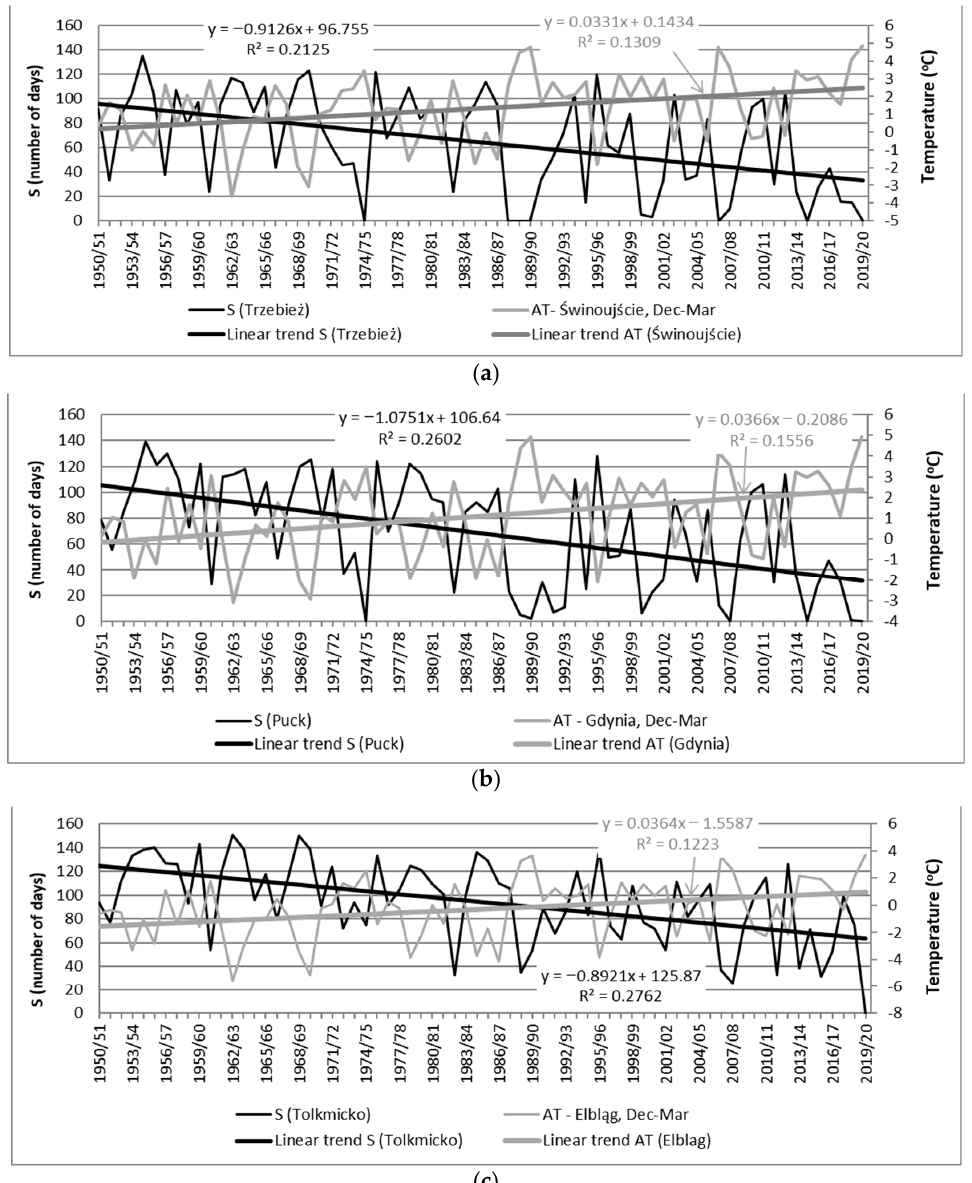
Figure 8. Variations and trend lines for ice season duration (S) on ( a ) Szczecin Lagoon; ( b ) Puck Lagoon; ( c ) Vistula Lagoon, and winter (Dec–Mar) air temperature (AT), along with the regression line equation and determination coefficient R 2 (AT data span 1950/51–2019/20).